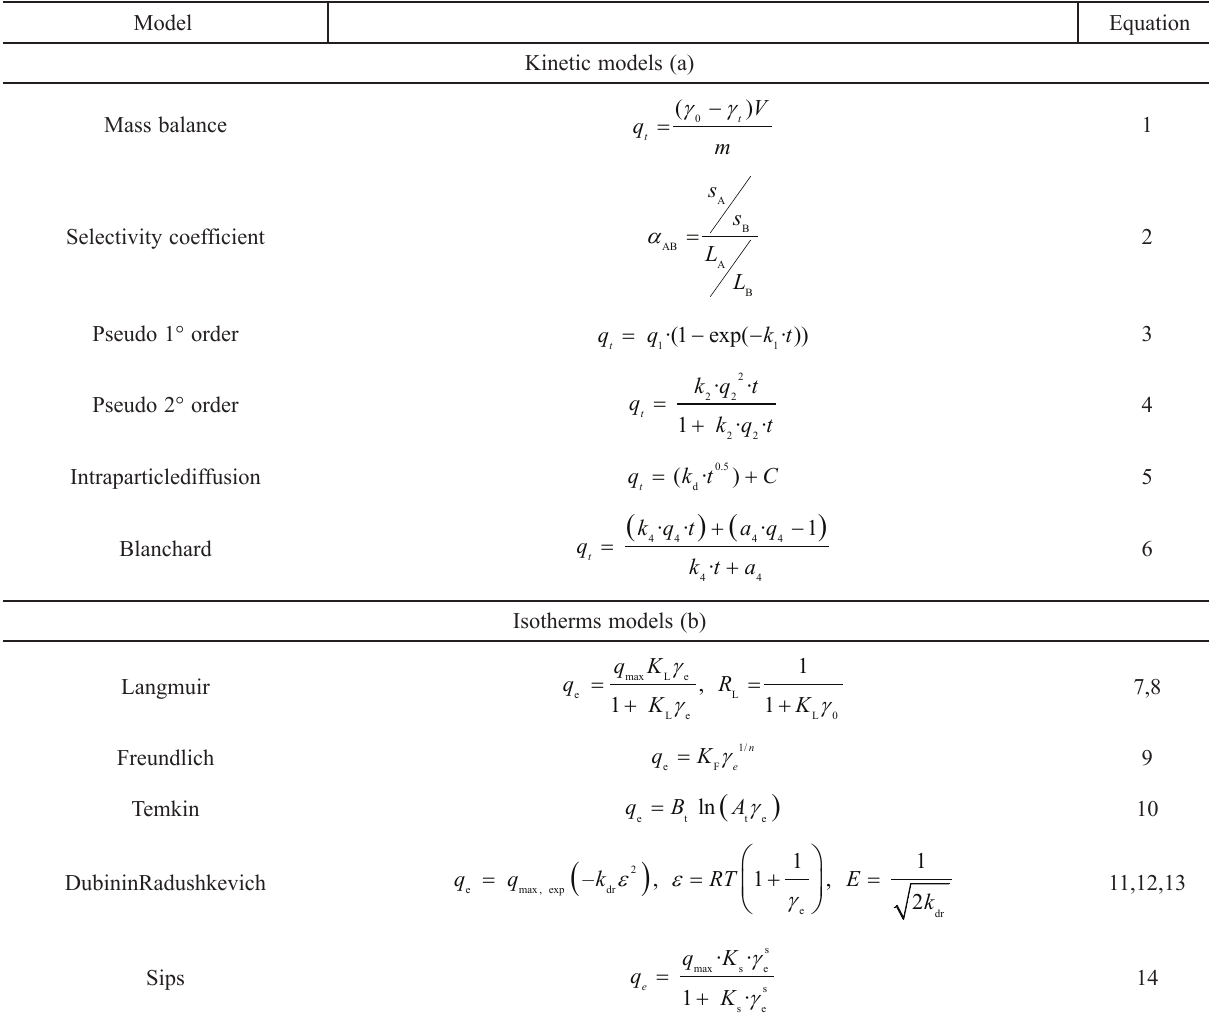
Table 1 – Model and equation used to calculate the kinetic (a) and isothermal (b) parameters